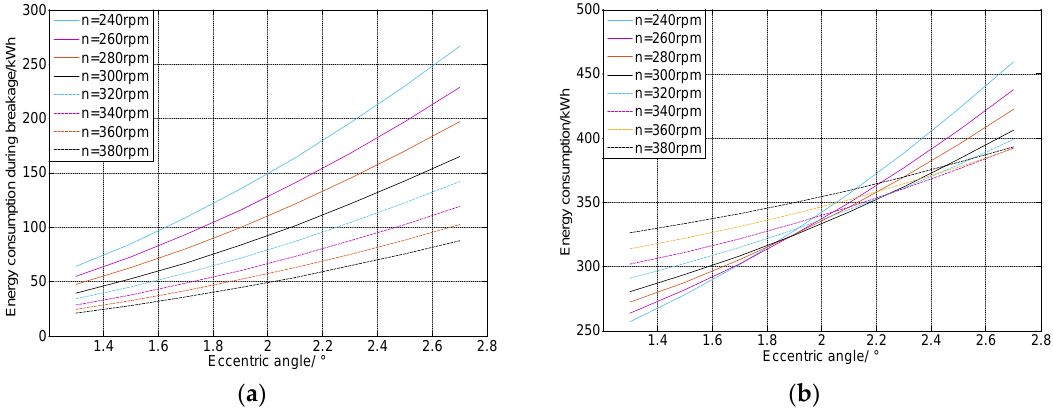
Figure 10. Energy consumption for various eccentric angle and speed: ( a ) relation of eccentric angle vs. breakage energy consumption; ( b ) relation of eccentric angle vs. energy consumption of cone crusher.